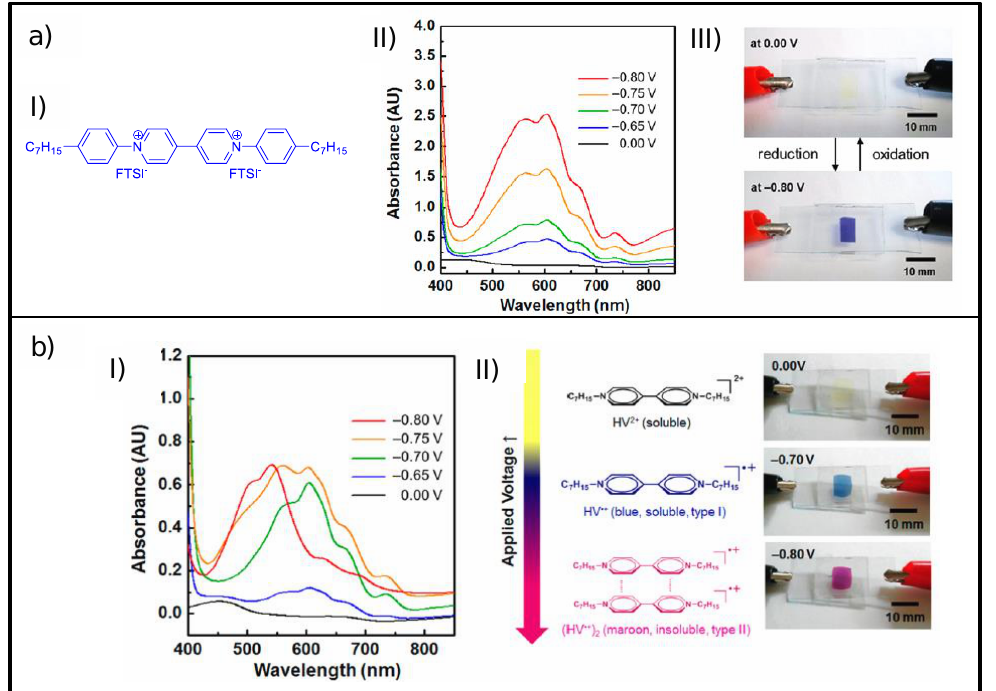
Figure 8. ( a ) EC system based on EC gel comprising BMI-TFSI: ( I ) Chemical structure of heptylviologen bis(trifluoromethane)sulfonamide; ( II ) evolution of UV-Vis spectra at different applied voltages; ( III ) photographs of ECD at bleached (0.00 V) and blue-colored (−0.80 V) state. ( b ) EC system based on EC gel comprising BMI-BF 4 : ( I ) evolution of UV-Vis spectra at different applied voltages; ( II ) photographs of ECD at three different states: bleached (0.00 V), blue-colored (−0.70 V), and red-colored (−0.80 V), along with the corresponding chemical species. Adapted with permission from [94], copyright (2016) American Chemical Society.